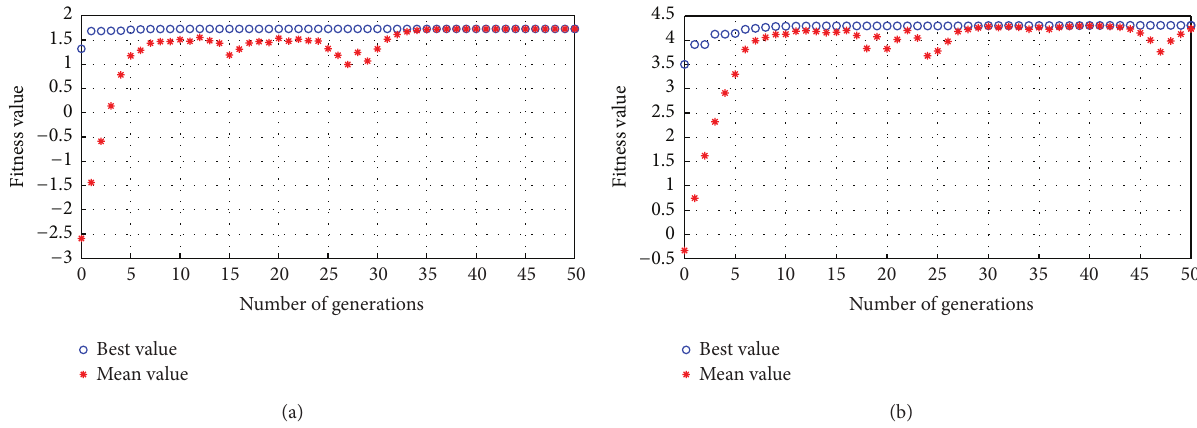
Figure 2: Evolution of the mean and best values of fitness function for finding actuator-sensor locations when the first two modes are controlled, while the next three modes are the residual modes: (a) one actuator-sensor and (b) a pair of actuator-sensors.